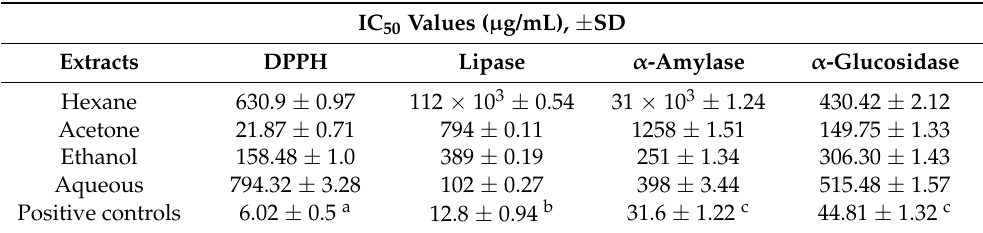
Table 1. Antioxidant, anti-lipase, anti- α -amylase, and anti- α -glucosidase activities IC 50 values ( µ g/mL) of Artemisia scoparia four extracts and positive